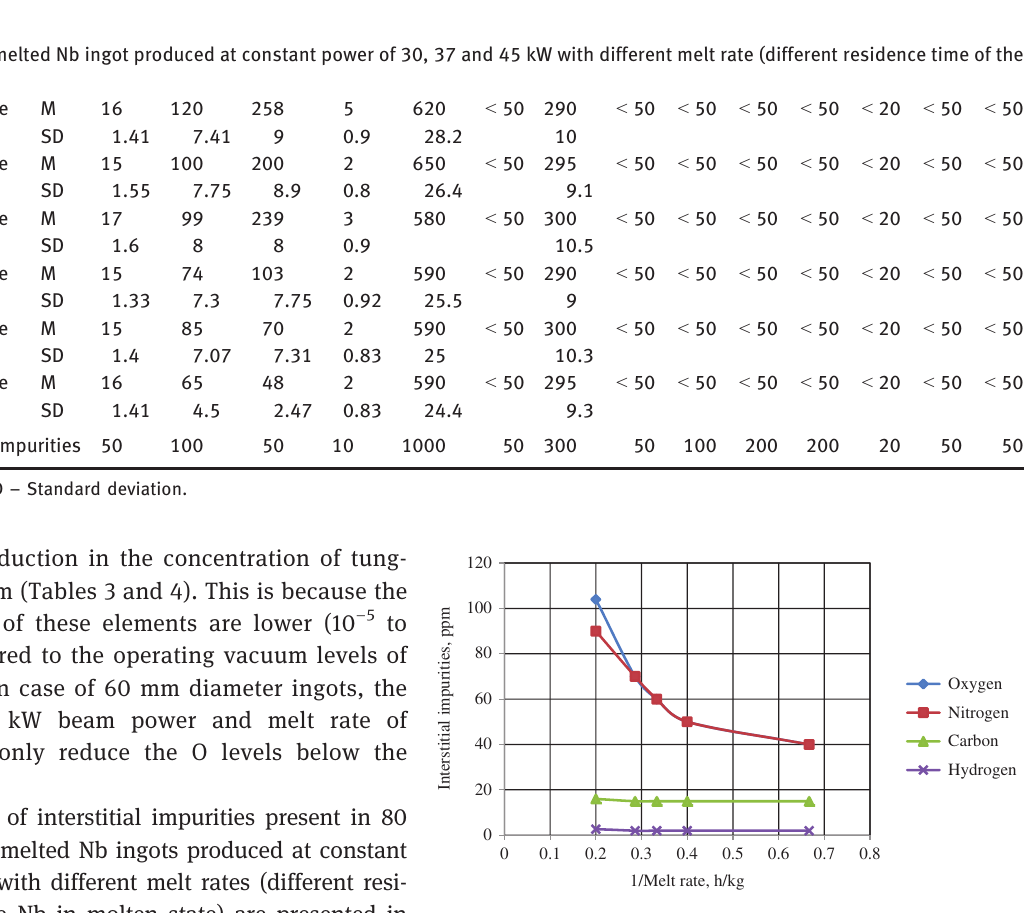
Figure 2: Effect of melt rate on removal of interstitial impurities from niobium during EB melting (Ingot diameter: 80 mm diameter and power: 45